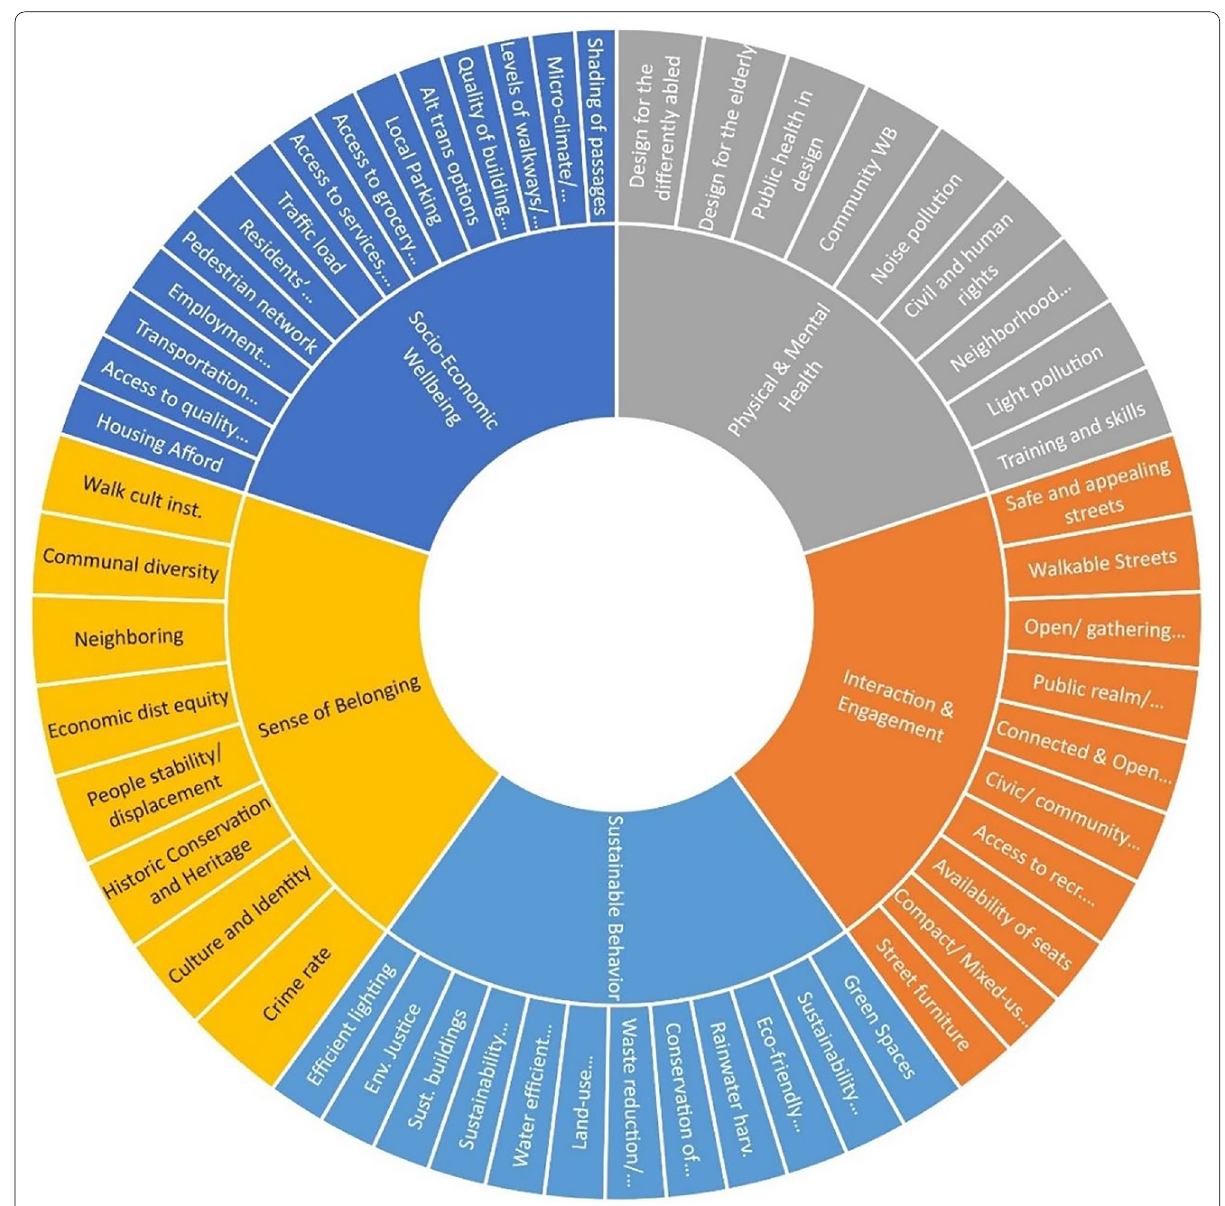
Fig. 10 The overall social sustainability rating